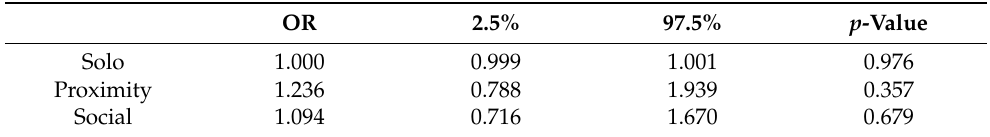
Table 7. Standard errors (SE), odds ratio (OR) with 95% CI, and z-statistics and p values for joint frequency